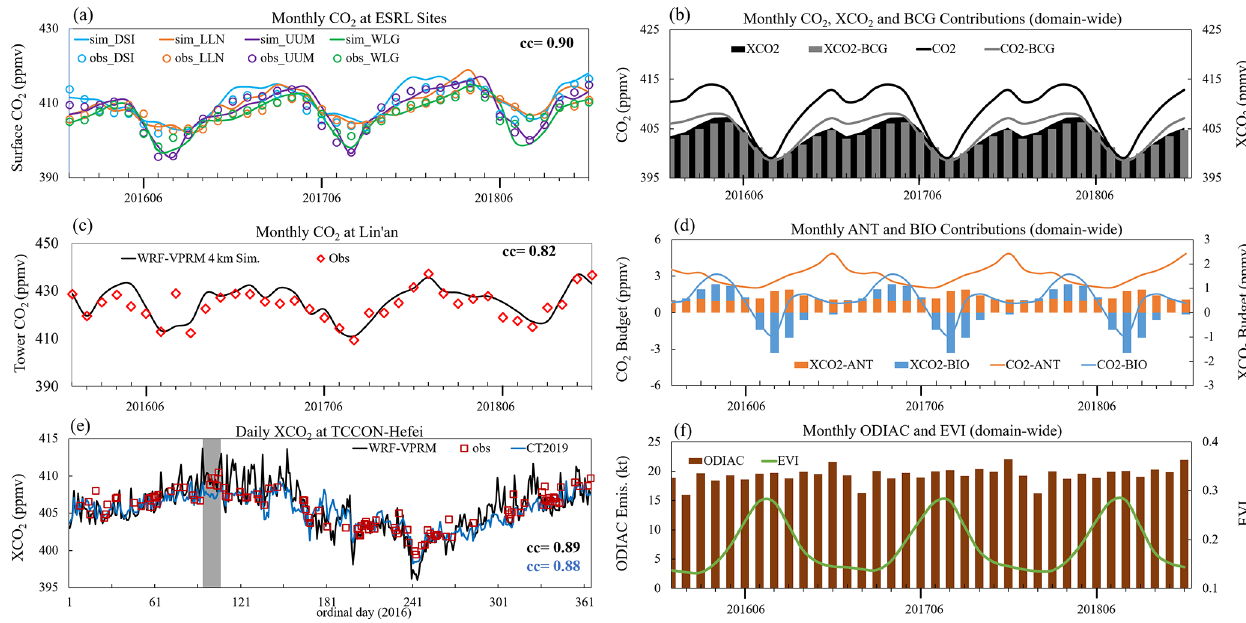
Figure 5. Monthly variations of (a) CO 2 at ESRL sites, (b) total (black) and background (BCG, grey) CO 2 (line) and XCO 2 (area and bar), (c) CO 2 at Lin’an station (averaged for daytime 21 and 55m data). (d) Contributions from anthropogenic (ANT, orange) and biogenic (BIO, blue) for CO 2 (lines) and XCO 2 (bars); (f) ODIAC emission and MODIS EVI; and (e) daily variation of XCO 2 at the TCCON Hefei